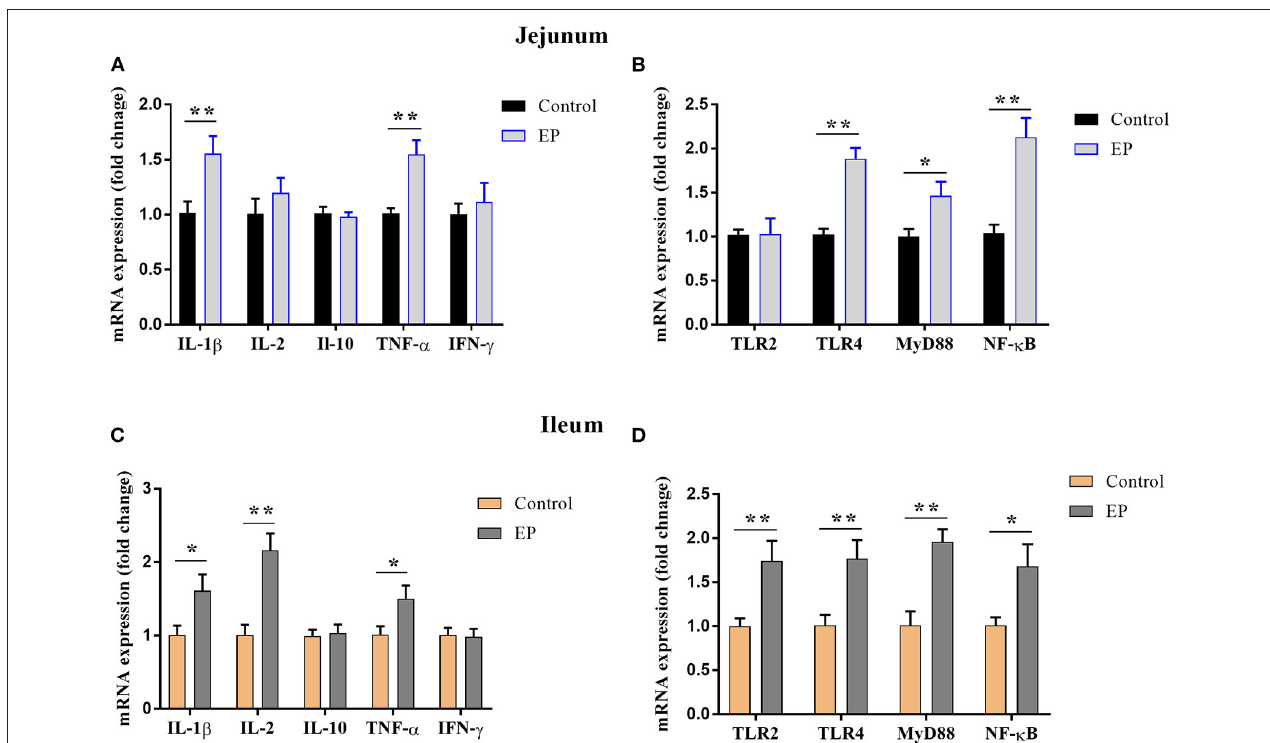
FIGURE 3 | Effects of EP supplementation on the expression of immune factor-related genes (A,C) and inflammatory signaling pathway genes (B,D) in the jejunum tissues (A,B) and ileum (C,D) of broiler chickens. Data are presented as mean ± SEM, n = 10. * P < 0.05 and ** P < 0.01, respectively. IL-1 β , Interleukin 1 beta; IL-2, Interleukin 2; IL-10, Interleukin 10; TNF- α , Tumor necrosis factor-alpha; IFN- γ , Interferon-gamma; TLR, Toll-like receptor; MyD88, myeloid differentiation 88; NF- κ B, Nuclear factor-kappa B.